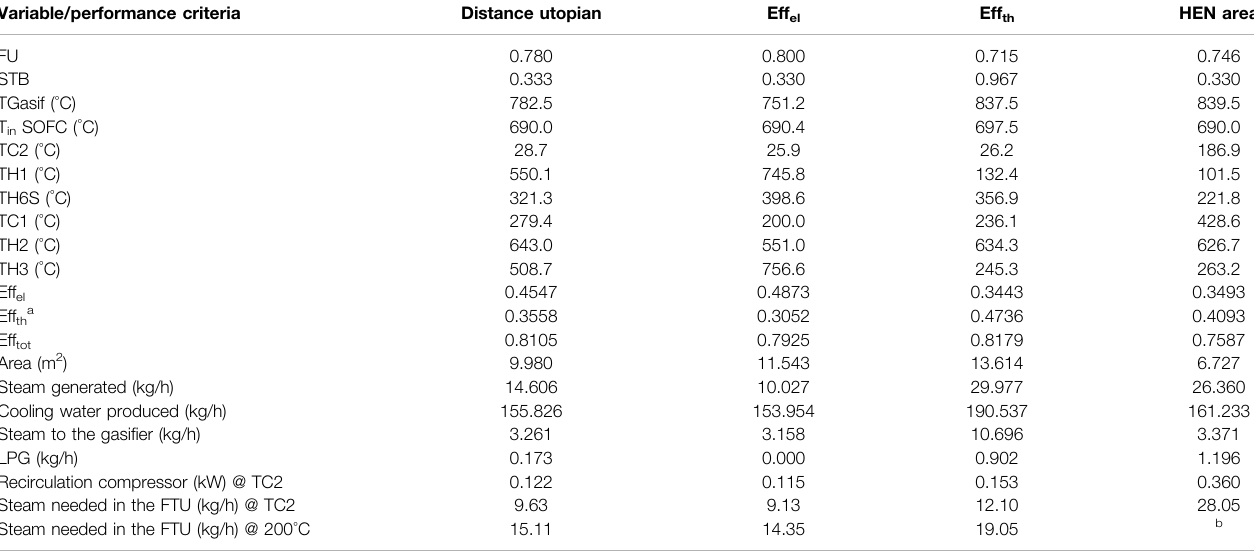
TABLE 9 | Selected optimal process designs (extremes of the Pareto front and closest point to the utopian point) and performance. Variable/performance criteria Distance utopian HEN area